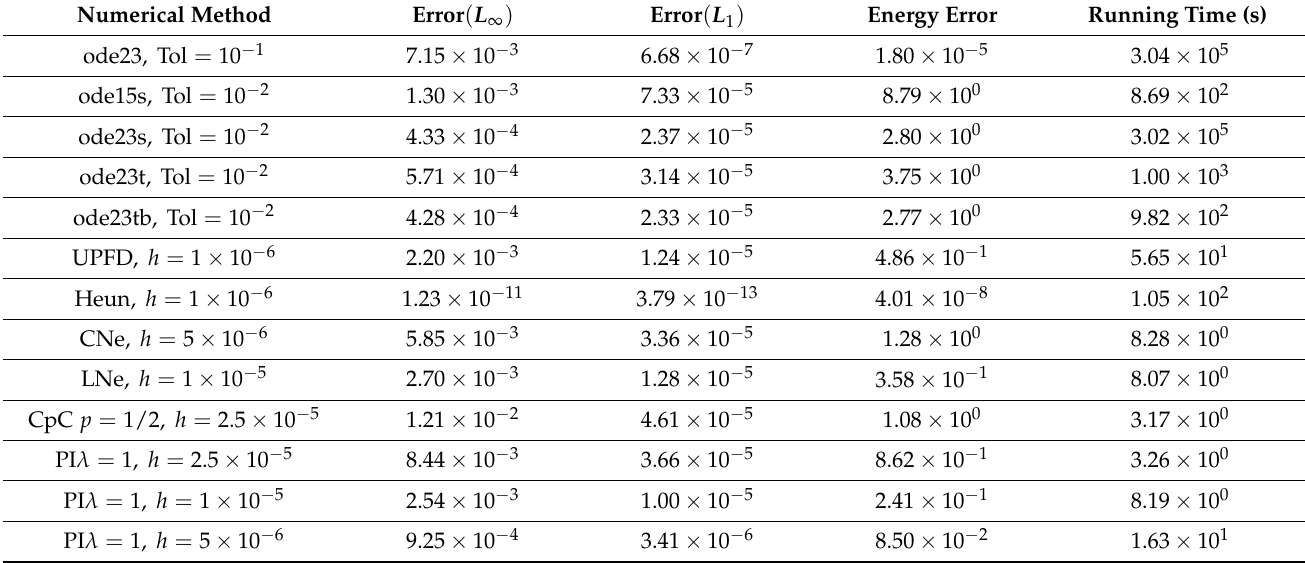
Table 1. Comparison of different algorithms for the extremely stiff system of twelve thousand